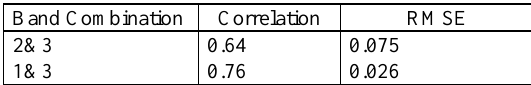
Table 3 . Interpretation of Correlation